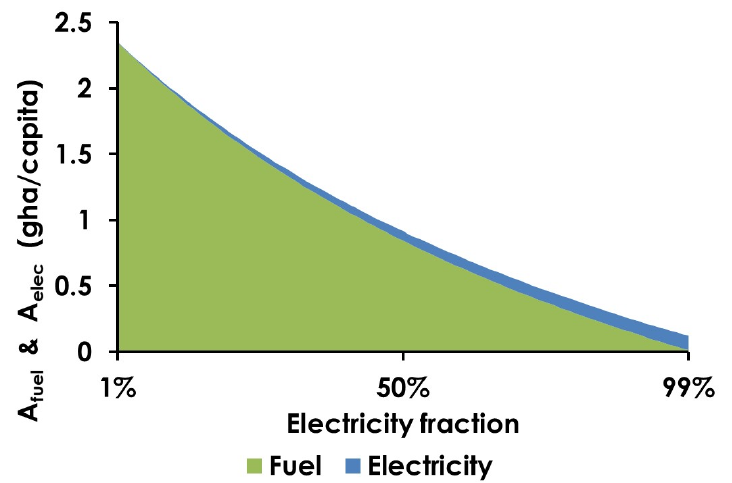
Figure 3. Degree of electrification versus Human Development Index.